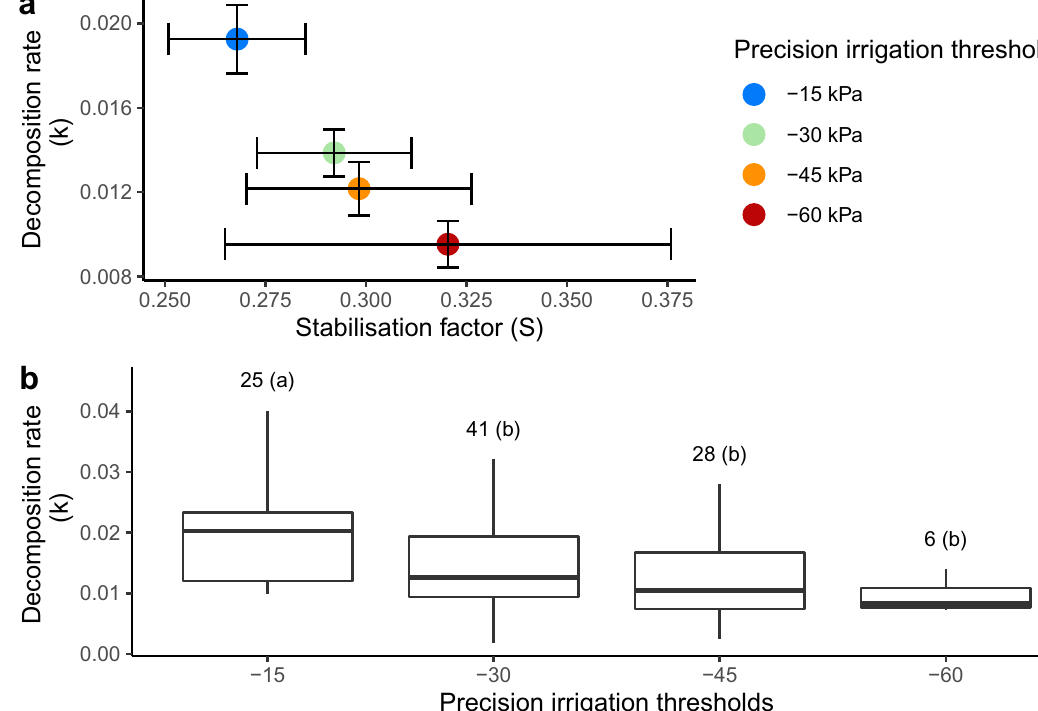
− 1 − 1 Figure 3. ( a ) The mean decomposition rate k (g g d ) and stabilization factor S of the tea bag index for each precision irrigation thresholds (colors) and experiment (shapes). Each point contains four replicates. Error bars are standard errors. ( b ) Decomposition rate (k) for each precision irrigation threshold. The numbers are the replicates of each treatment. The precision irrigation thresholds with different letters in parenthesis are significantly different.